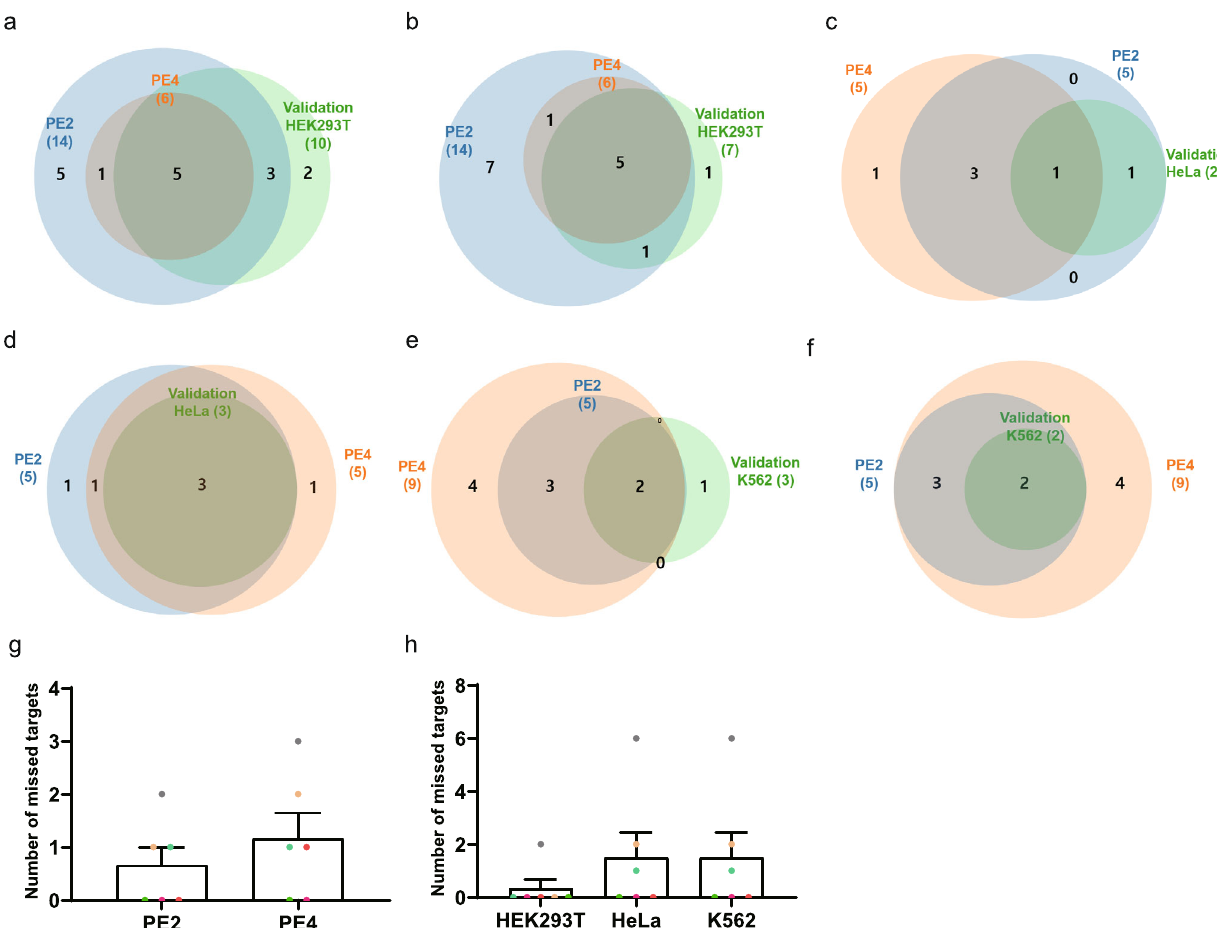
Fig. 3 | TAPE-seq analysis using PE2 and PE4 in different cell lines. a – f Venn diagrams showing the number of and overlap between validated off-target sites in PE2-transfected cell lines and the off-target sites predicted by TAPE-seq using PE2 or PE4 with the following pegRNAs and cell lines: a HEK4 (+2G to T) in HEK293T cells, b HEK4 (+3 TAA ins) in HEK293T cells, c HEK4 (+2G to T) in HeLa cells, d HEK4 (+3TAAins)inHeLacells, e HEK4 (+2G toT)inK562cells,and f HEK4